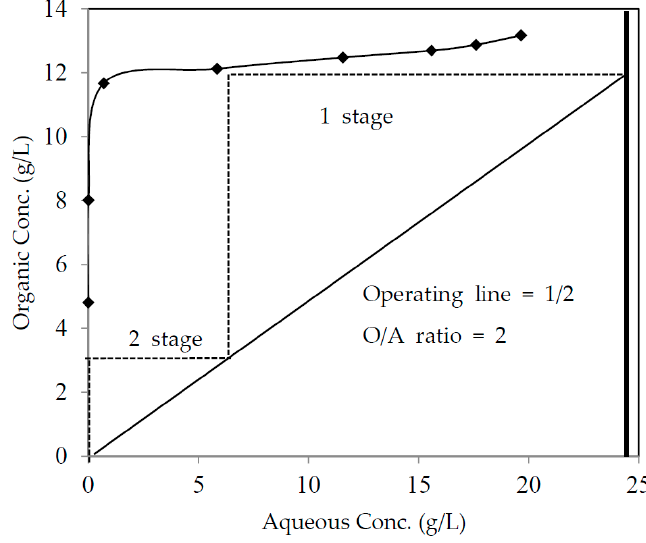
Figure 4. McCabe-Thiele diagram for cobalt extraction using 50% saponified 0.85 M Cyanex 272.